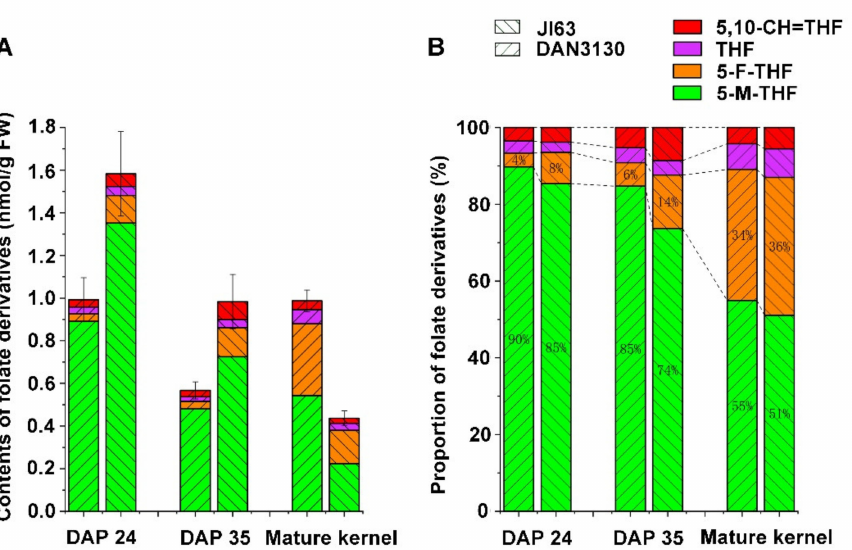
Figure 1. Folate profiling of maize kernel during late stages of development. ( A ) contents of folate derivatives on DAP 24, DAP 35, and mature kernels in DAN3130 and JI63. ( B ) the proportion of differ- ent folate derivatives. DAP, the day after pollination; 5-M-THF, 5-methyl-tetrahydrofolate; 5-F-THF, 5-formyl-tetrahydrofolate; 5,10-CH=THF, 5,10-methylene-tetrahydrofolate; THF,